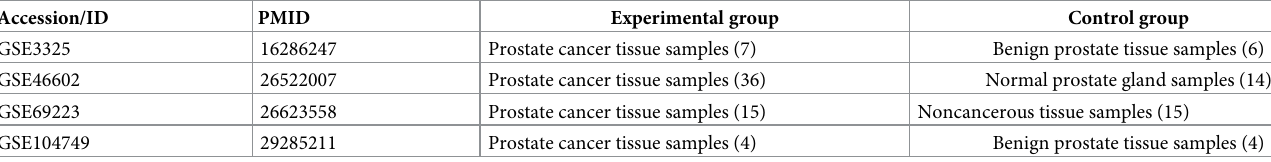
Table 1. Characteristics of the microarray